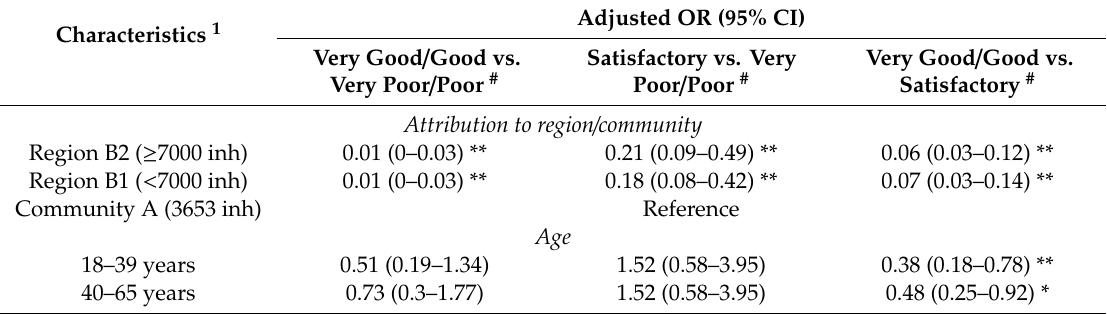
Table 3. Multinomial logistic regression model for outcome (1) “HCS provided by